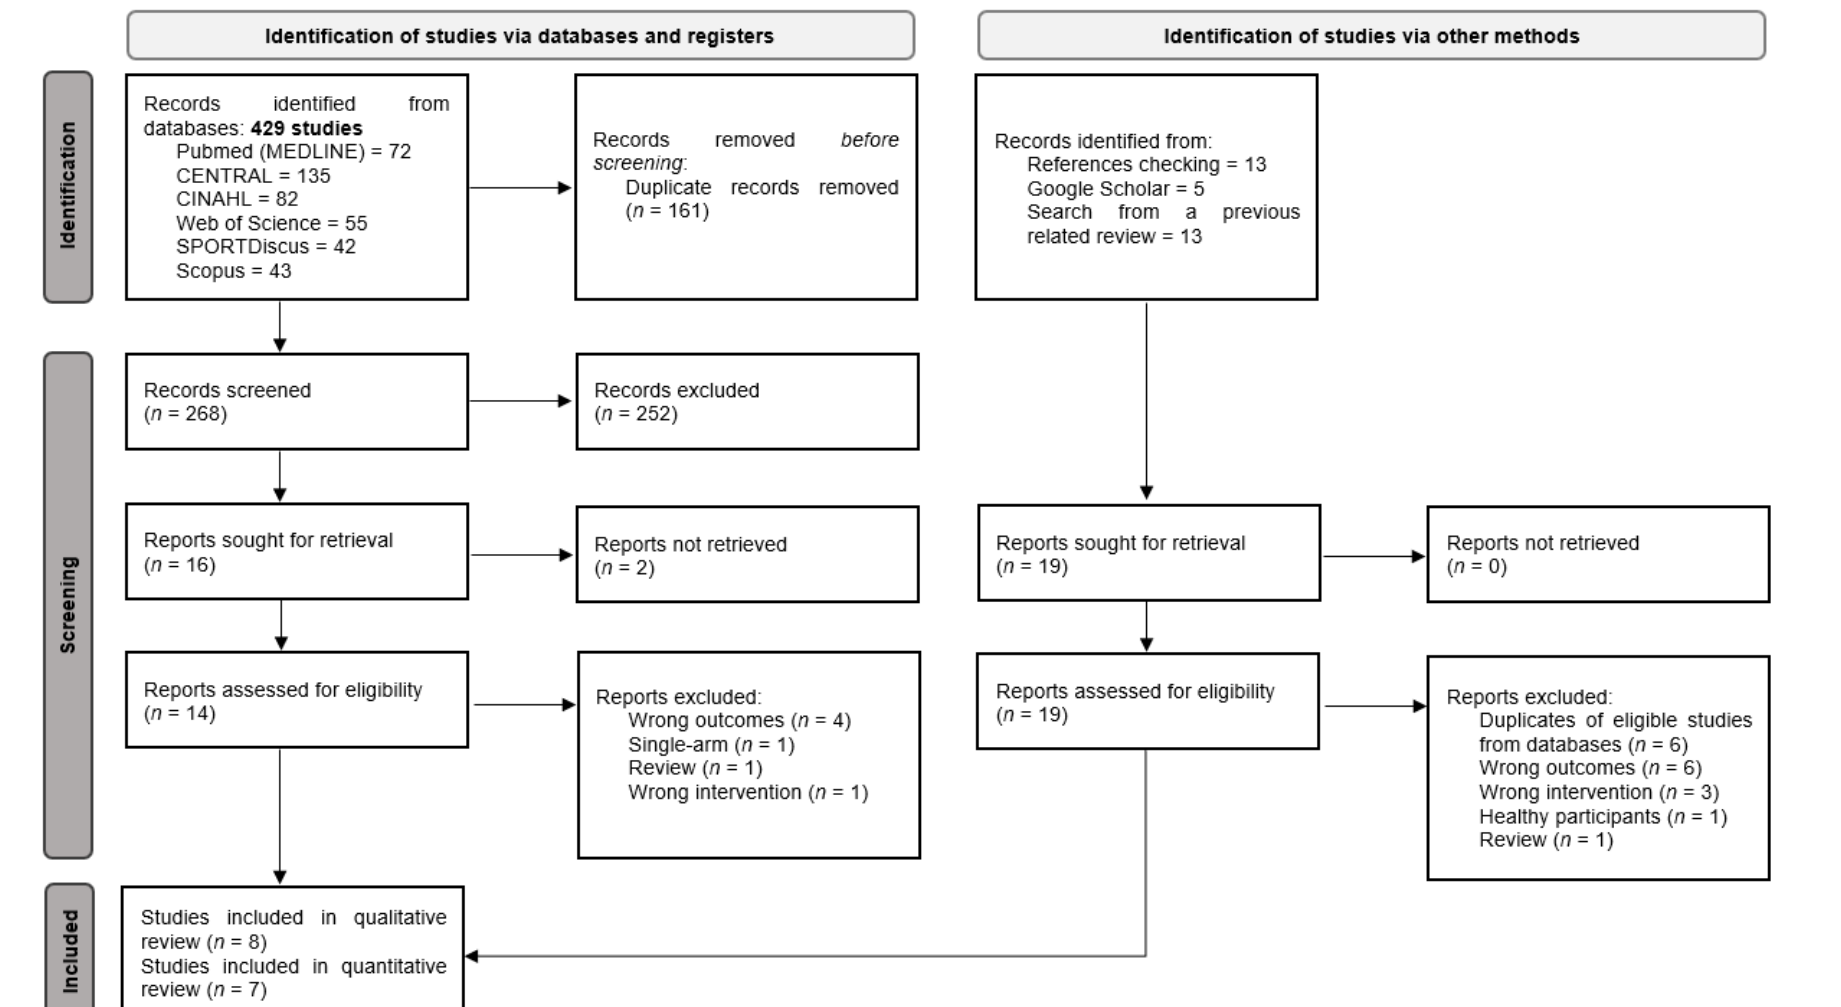
Figure A1. PRISMA 2020 flowchart of studies selection.